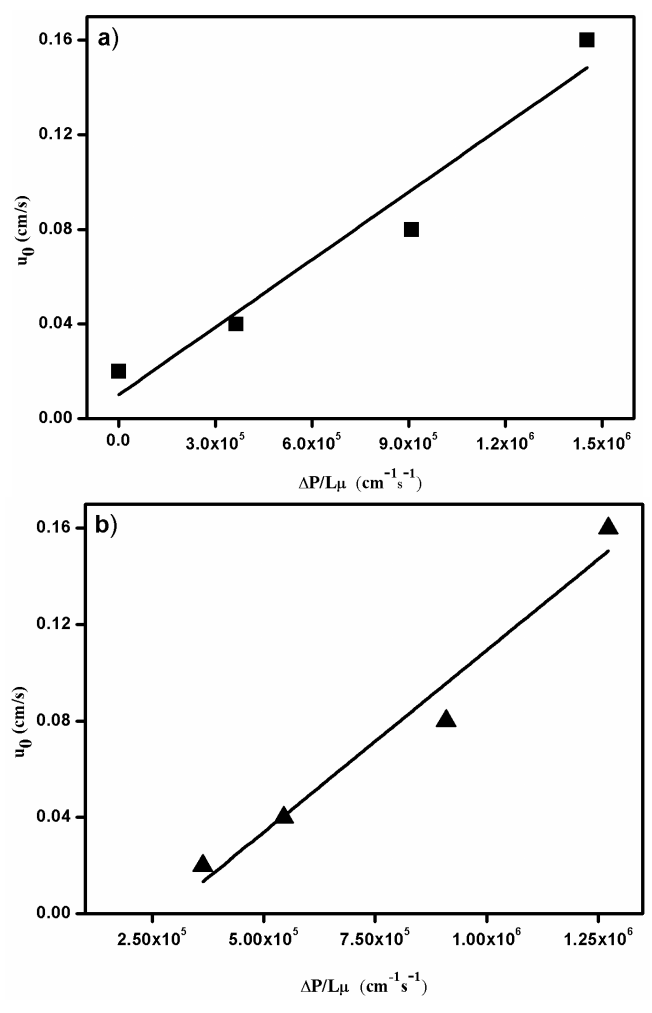
Figure 5. Superficial flow velocity versus pressure drop for a column packed with Q fibrous adsorbent. (■) 5 mm ID × 5.5 cm L -column ( a ); (▲) 50 mm ID × 5.5 cm L -column ( b